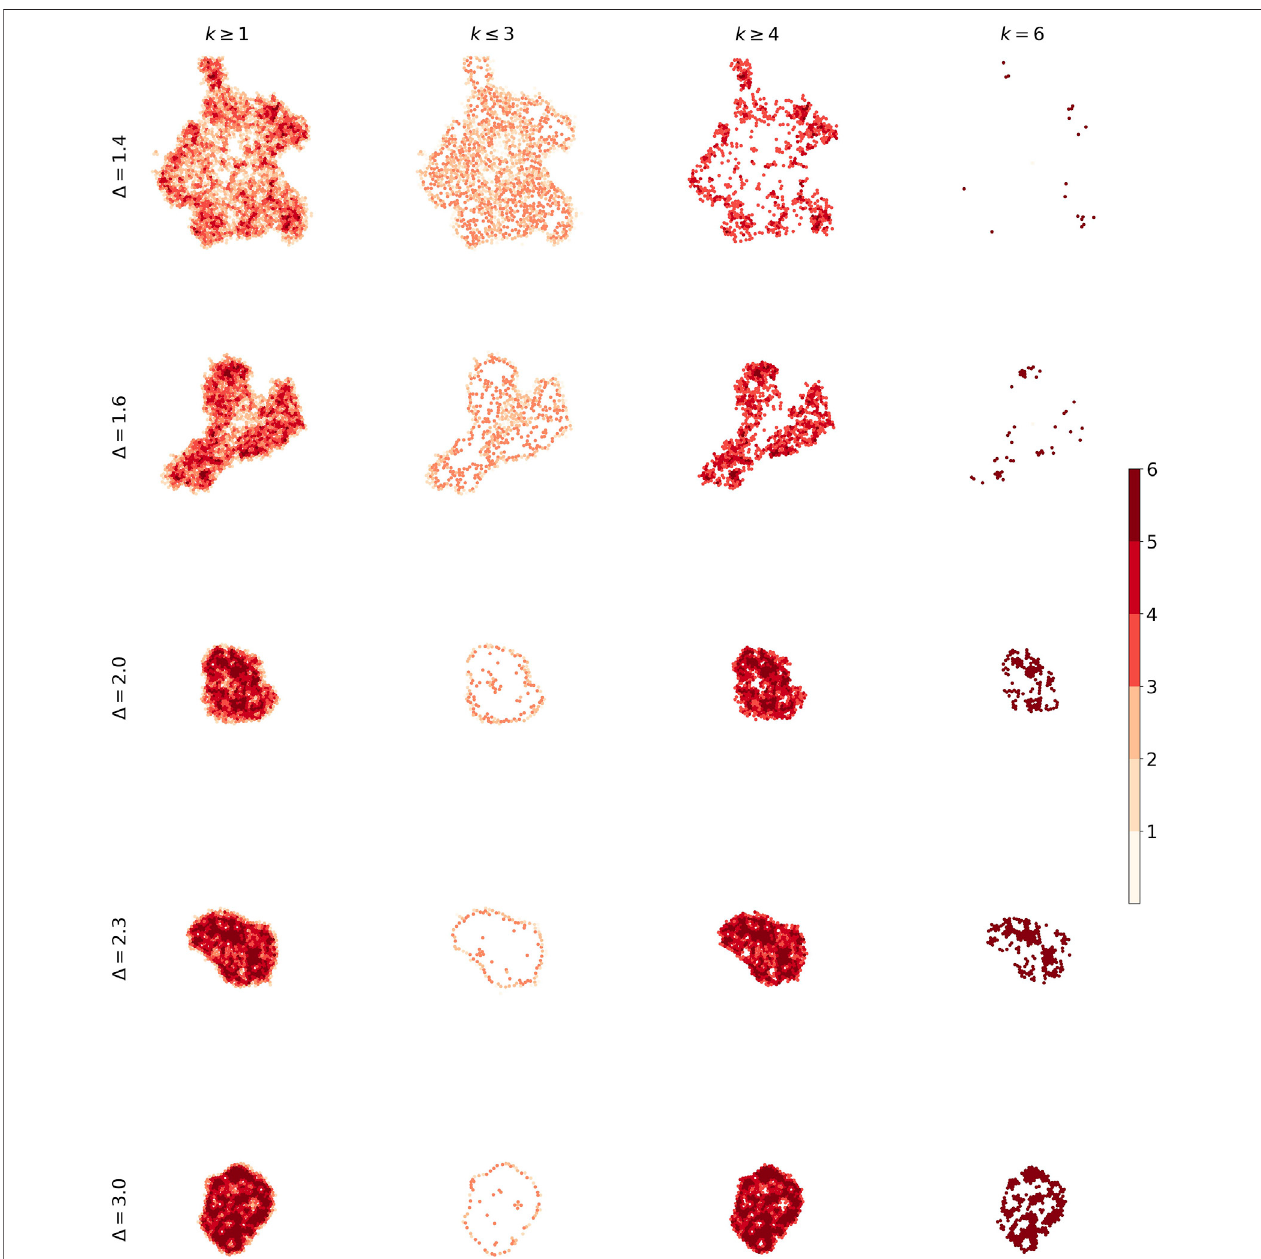
FIGURE 11 | The heat plot for fi ve tumors. We made difference between nodes according to their degrees in order to distinguish solidity of tumors.